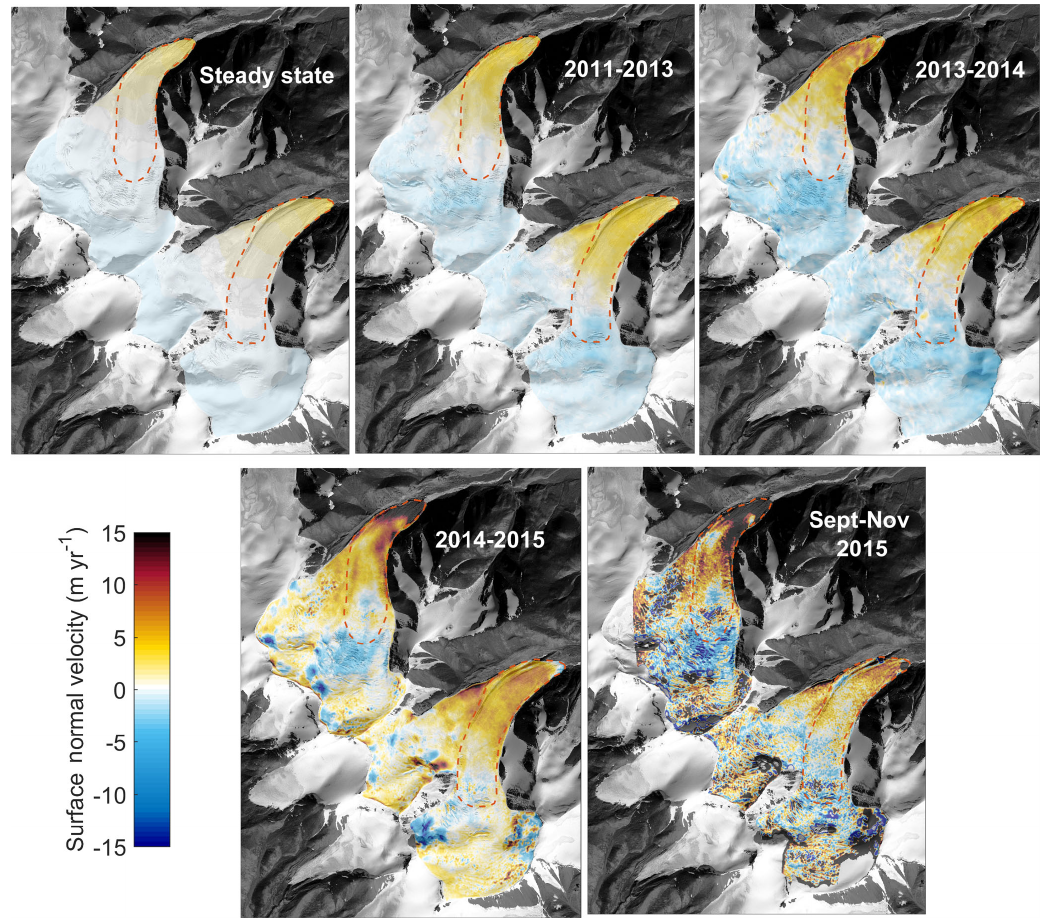
Figure 2. Mean emergence velocities obtained by differencing elevation changes from repeat DEMs and modelled mass balances during different periods prior to the collapses. Steady-state velocities in the first panel are modelled. Orange dashed lines indicate the detachment